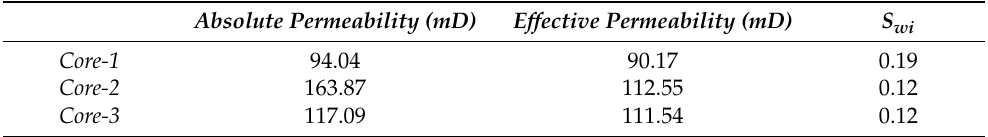
Table 3. Rock–fluid interaction properties for samples used in oil displacement tests.